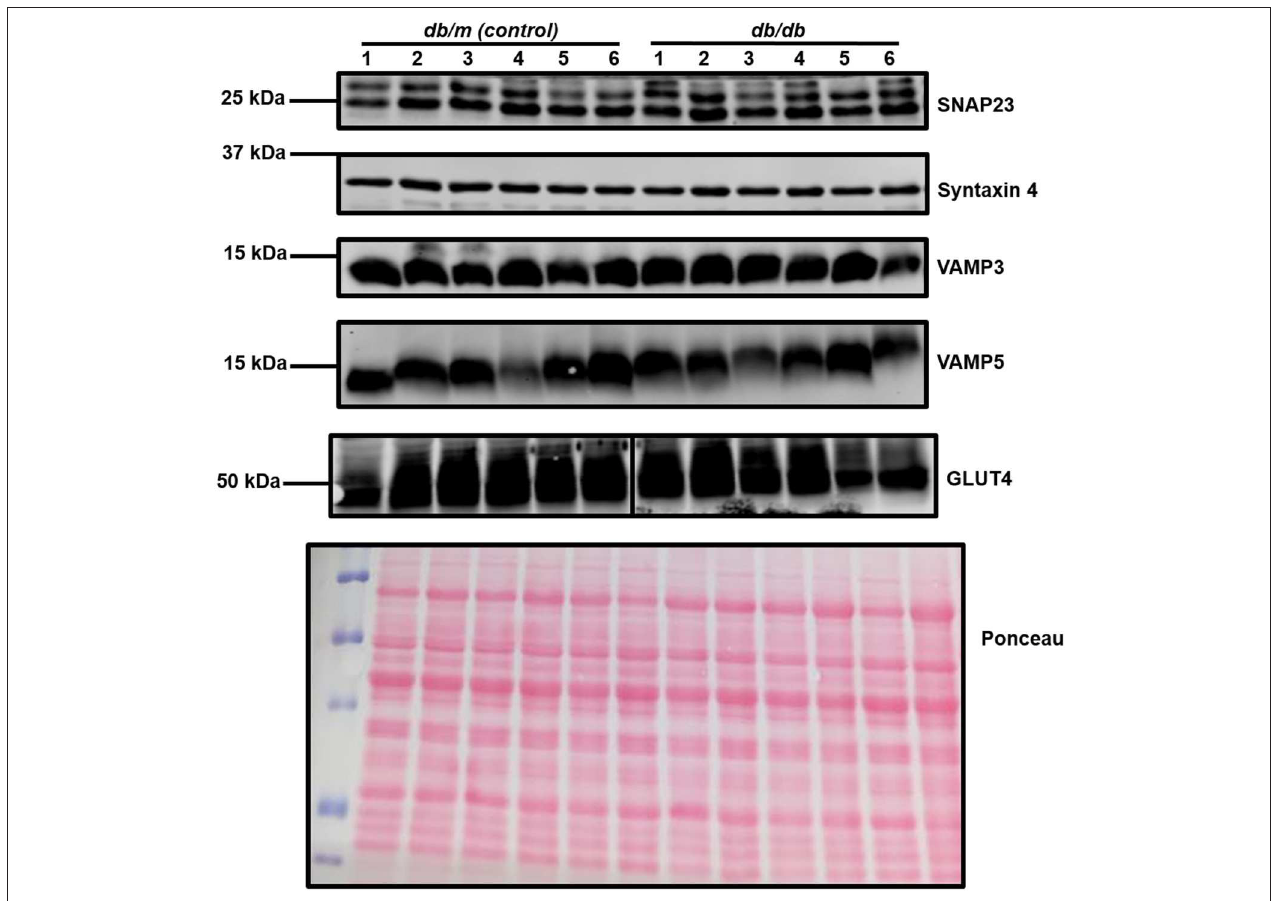
FIGURE 2 | Cardiac SNARE expression in db/db and db/m mice. Protein lysates were generated from db/db and control mouse hearts and subjected to SDS-PAGE and immunoblotting, probing for the expression of numerous SNARE proteins and GLUT4. Representative immunoblots for selected proteins only are shown. A representative Ponceau S staining of a membrane is displayed, which was used as a loading control. For each sample, 40 µ g of protein lysate was loaded. Each sample (1–6 on figure) is composed of lysate generated from a separate